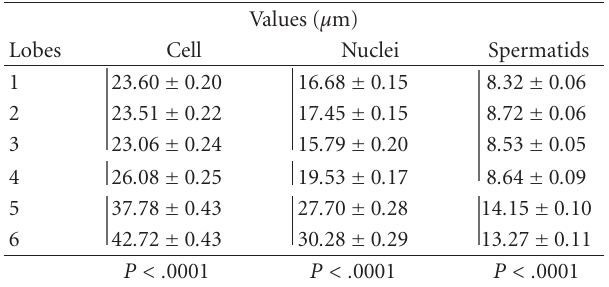
Table 2: Mean diameter of cells in di ff use stage and their respective nuclei and round spermatids of Euschistus heros , chosen randomly. The lateral bars indicate di ff erent groups with equality average. The values are given by Mean ± standard deviation (Mean ± SD). The unit utilized is micrometers ( µ